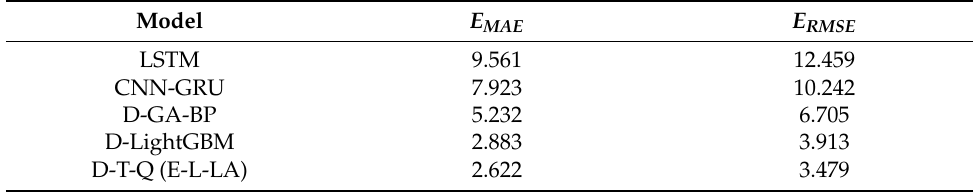
Table 6. Prediction errors across